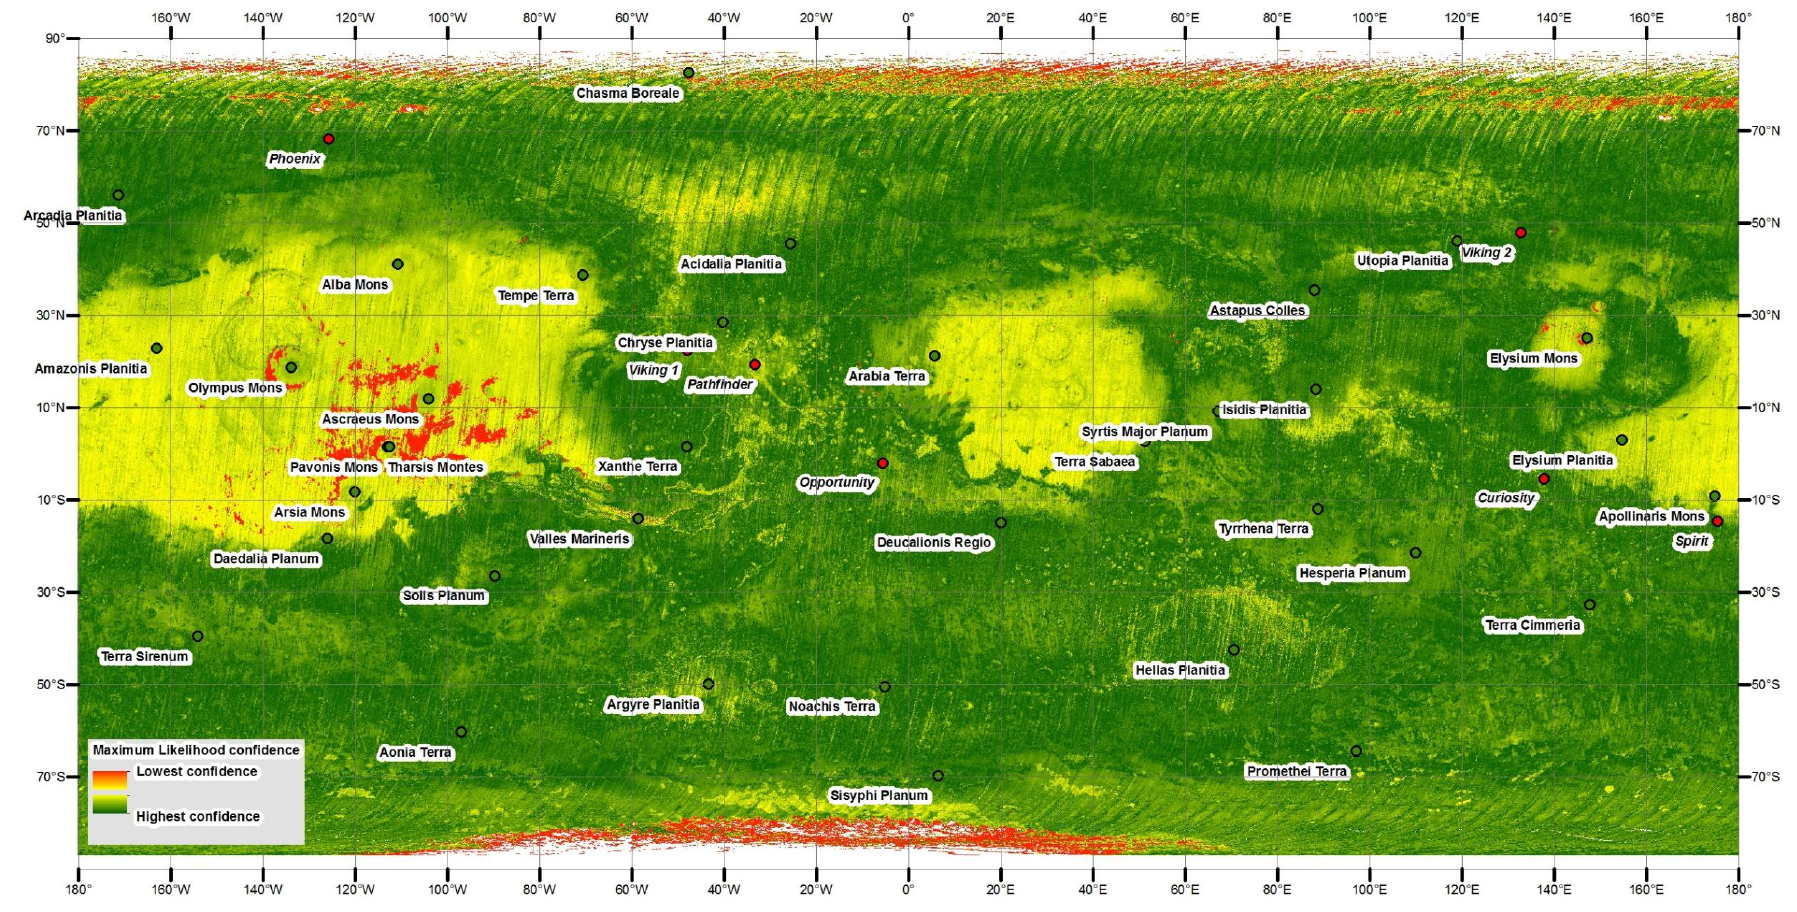
Figure 10. Global map of classification confidence based on pixel distance values from the combined ISODATA and MAXLIKE